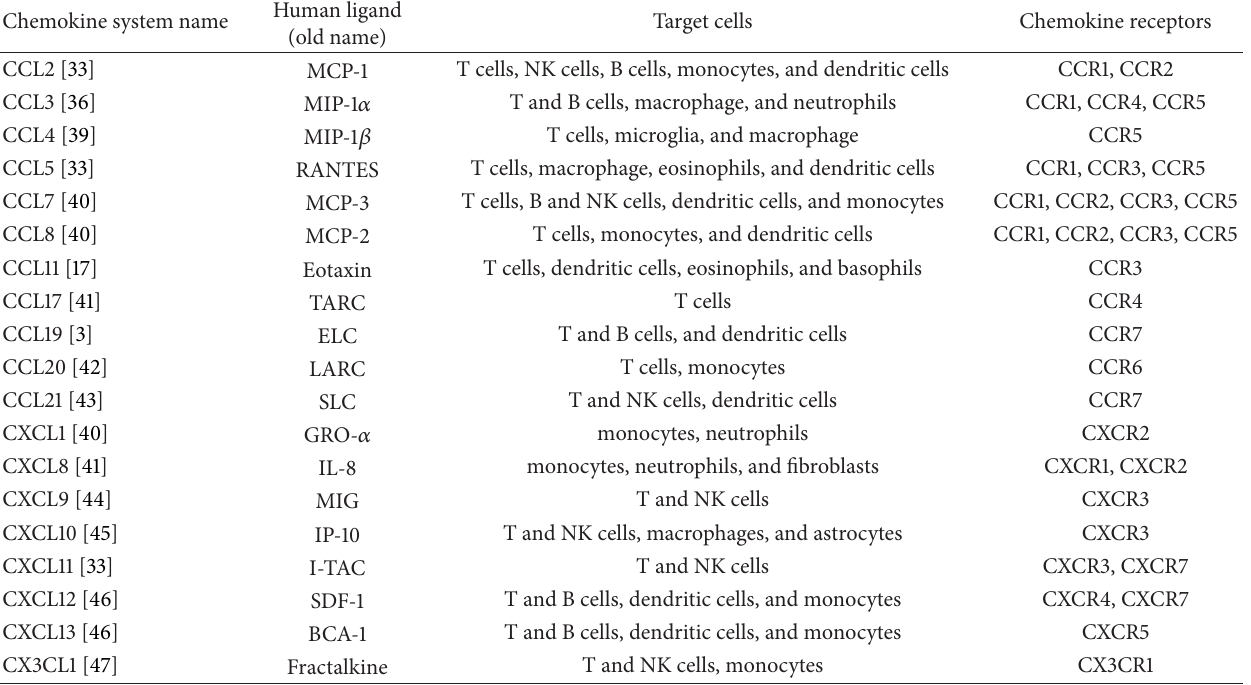
Table 1: Chemokines described in patients with